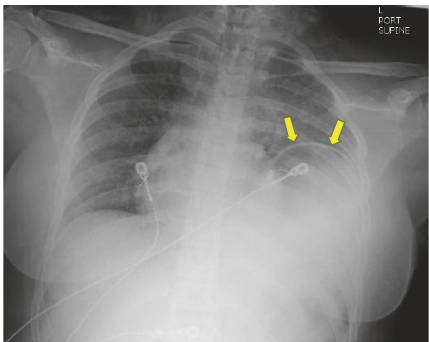
Figure 1: Portable supine chest radiograph shows suspected elevation of the left hemidiaphragm (yellow arrows) with underlying haziness and air-filled viscus over the lower left hemithorax. In retrospect, the suspected “elevated” diaphragmatic contour actually represents the wall of the stomach that herniated through a diaphragmatic hiatus.